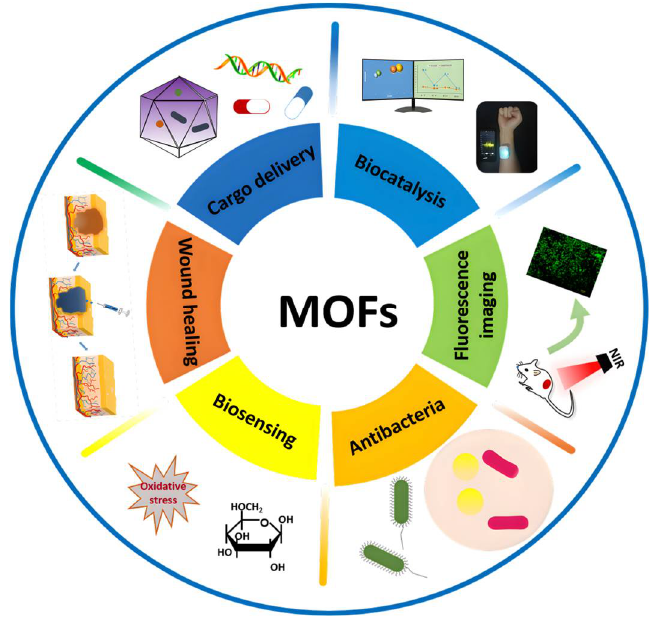
Figure 1. Applications of MOFs in the biomedical field.